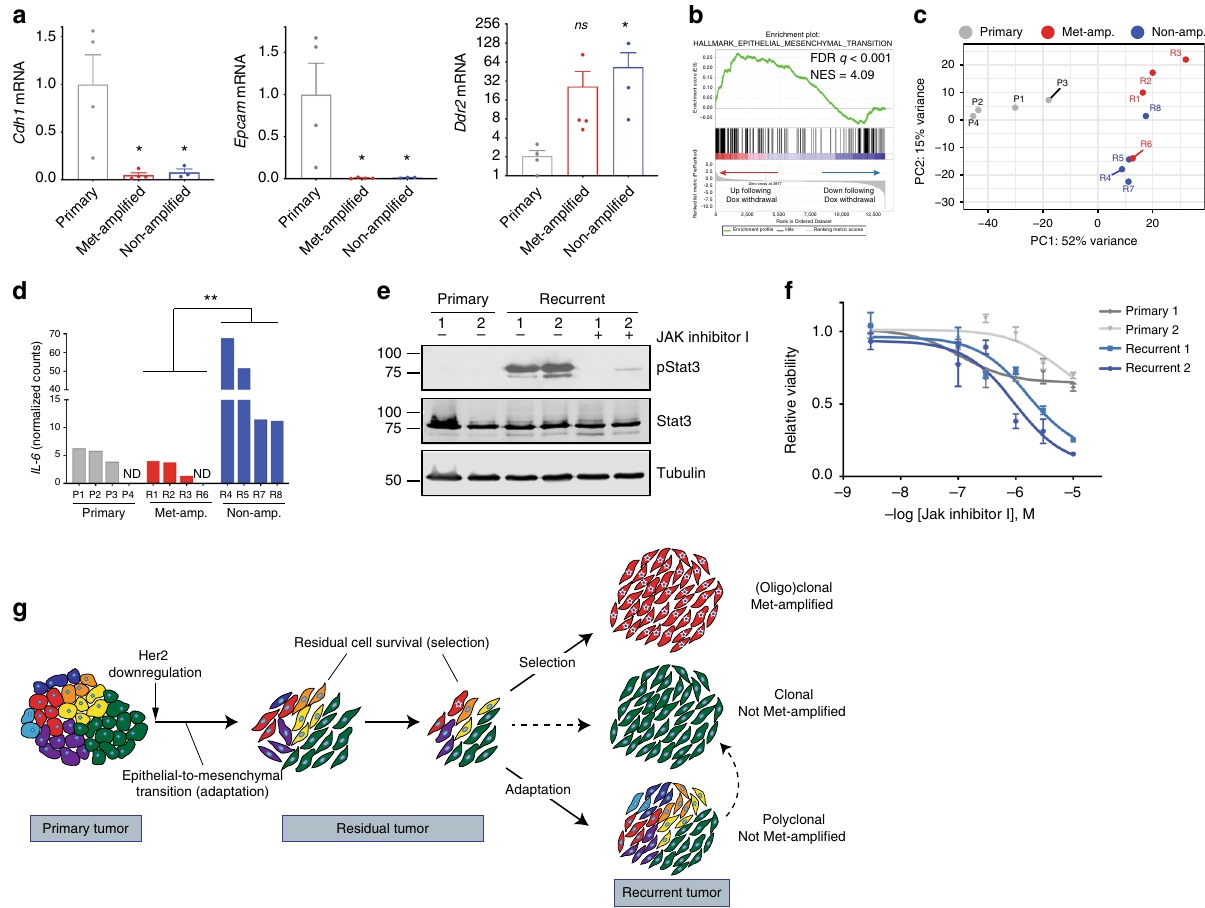
Fig. 5 Polyclonal recurrent tumors have distinct gene expression pro fi les. a qRT-PCR analysis showing expression of epithelial (Cdh1 and Epcam) and mesenchymal (Ddr2) markers in primary tumors, Met-ampli fi ed recurrent tumors, and non-ampli fi ed recurrent tumors. Signi fi cance was determined using one-way ANOVA with Dunnett ’ s multiple comparison testing. * P < 0.05 between each recurrent cohort and the primary tumor cohort. Cdh1: primary vs met-ampli fi ed, P = 0.015; primary vs. non-ampli fi ed, P = 0.025. Epcam: primary vs met-ampli fi ed, P = 0.027; primary vs. non-ampli fi ed, P = 0.039. Ddr2: primary vs met-ampli fi ed, P = 0.11; primary vs. non-ampli fi ed, P = 0.01. n = 4 biologically independent primary tumors, n = 4 biologically independent Met- ampli fi ed recurrent tumors, and n = 3 biologically independent non-Met-ampli fi ed recurrent tumors in each cohort. Data are presented as mean ± SEM. b Gene set enrichment analysis showing enrichment of an EMT signature in cells following Her2 downregulation in vitro. Normalized enrichment score was calculated using the Kolmogorov – Smirnov statistic. To correct for multiple testing, the FDR q -value was estimated using permutation testing to compare the actual NES to random gene sets. c Principal components analysis (PCA) of gene expression pro fi les in primary tumors, and recurrent tumors with and